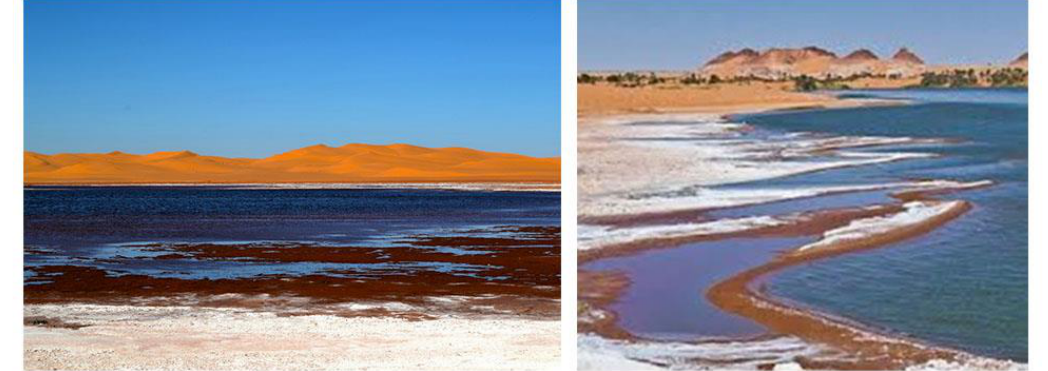
Figure 7 The landscape of Sebkha; Salt Lake of